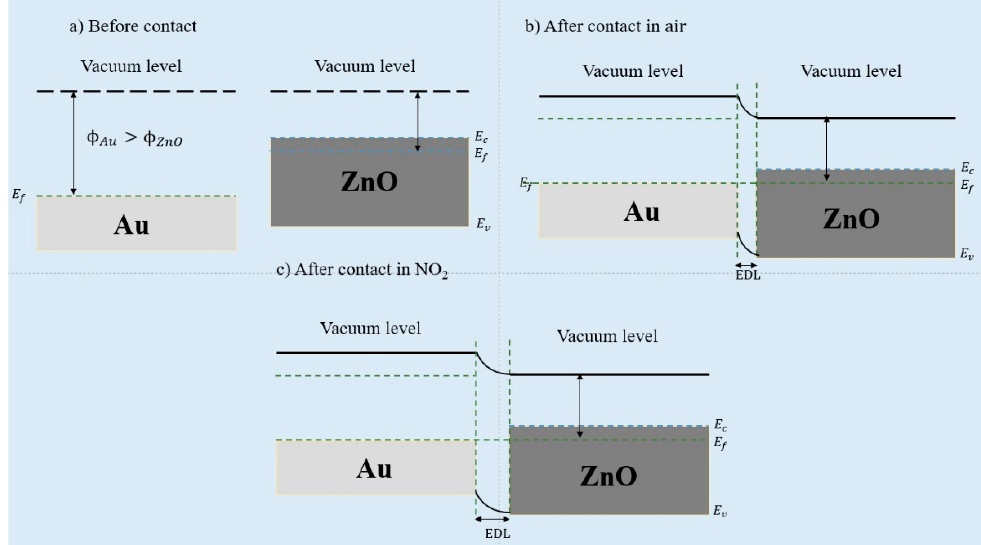
Figure 16. ( a ) Energy level of Au and ZnO before contact. Formation of Schottky barriers between Au and ZnO in ( b ) air and ( c ) NO 2 gas.